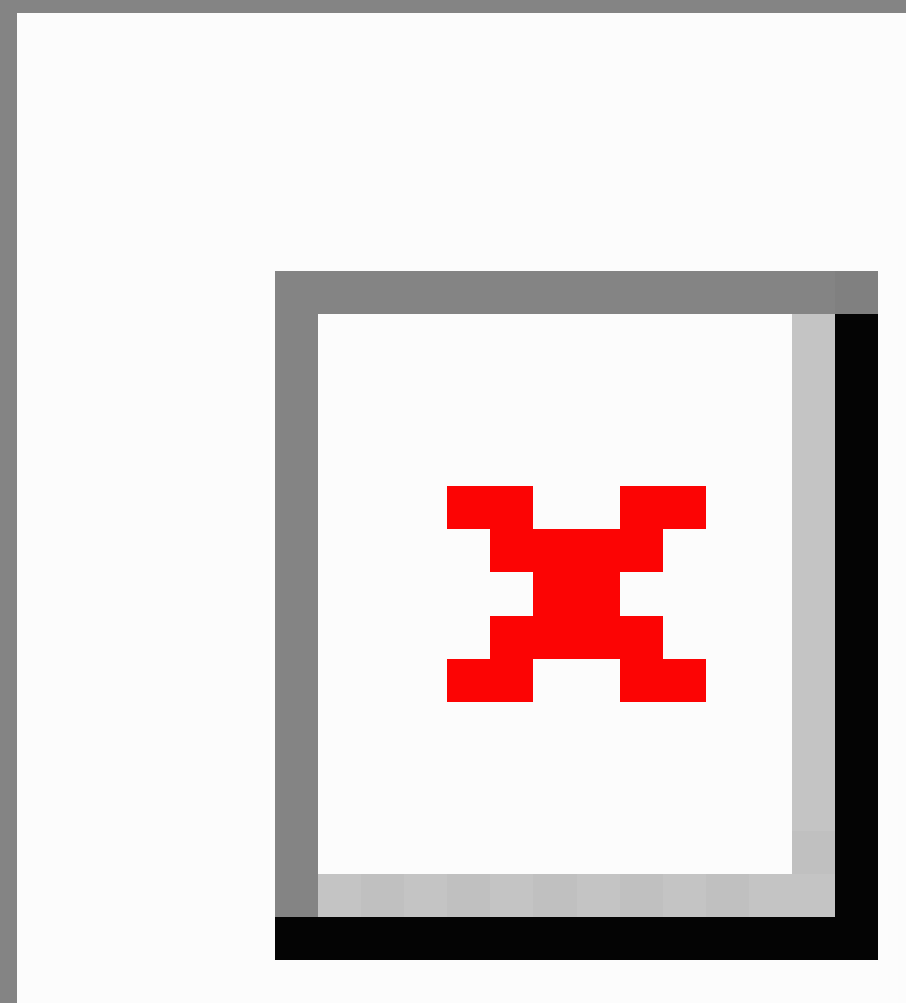
Figure 1. Screenshot of Phobias Under Control: fear